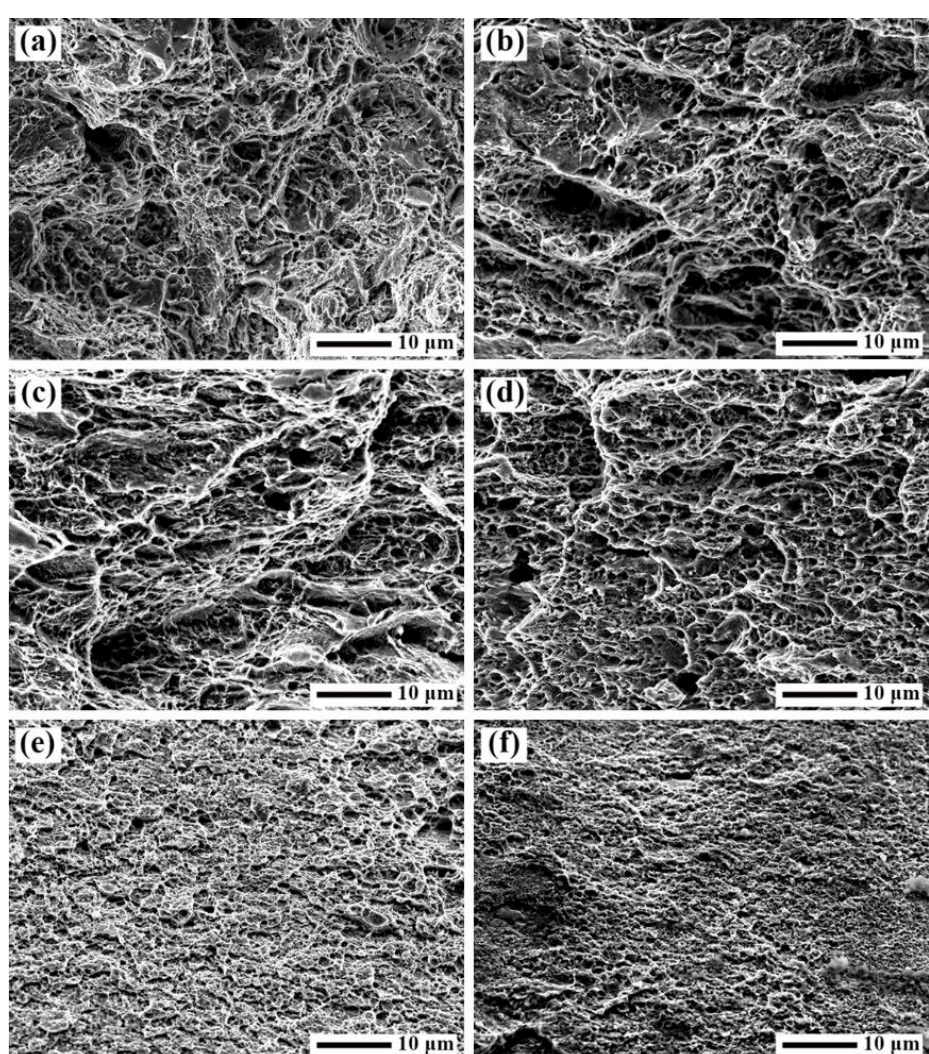
Figure 3. SEM micrographs showing the tensile fracture surfaces of the SK85 steel before cold rolling ( a ) and at a rolling reduction of ( b ) 10%; ( c ) 30%; ( d ) 50%; ( e ) 70%; and ( f ) 90%. The EBSD orientation maps of the rolling direction-transverse direction (RD-TD) planes of the SK85 steel at different rolling reductions are shown in Figure 4. The insets are the corresponding {001} pole figures, and {001} is perpendicular to the normal direction (ND). The blue, red, and green represent the <111>, <001>, and <110> directions, respec- tively. Before rolling the initial texture is randomized and a strong {001} <110> texture is obtained at a 90% rolling